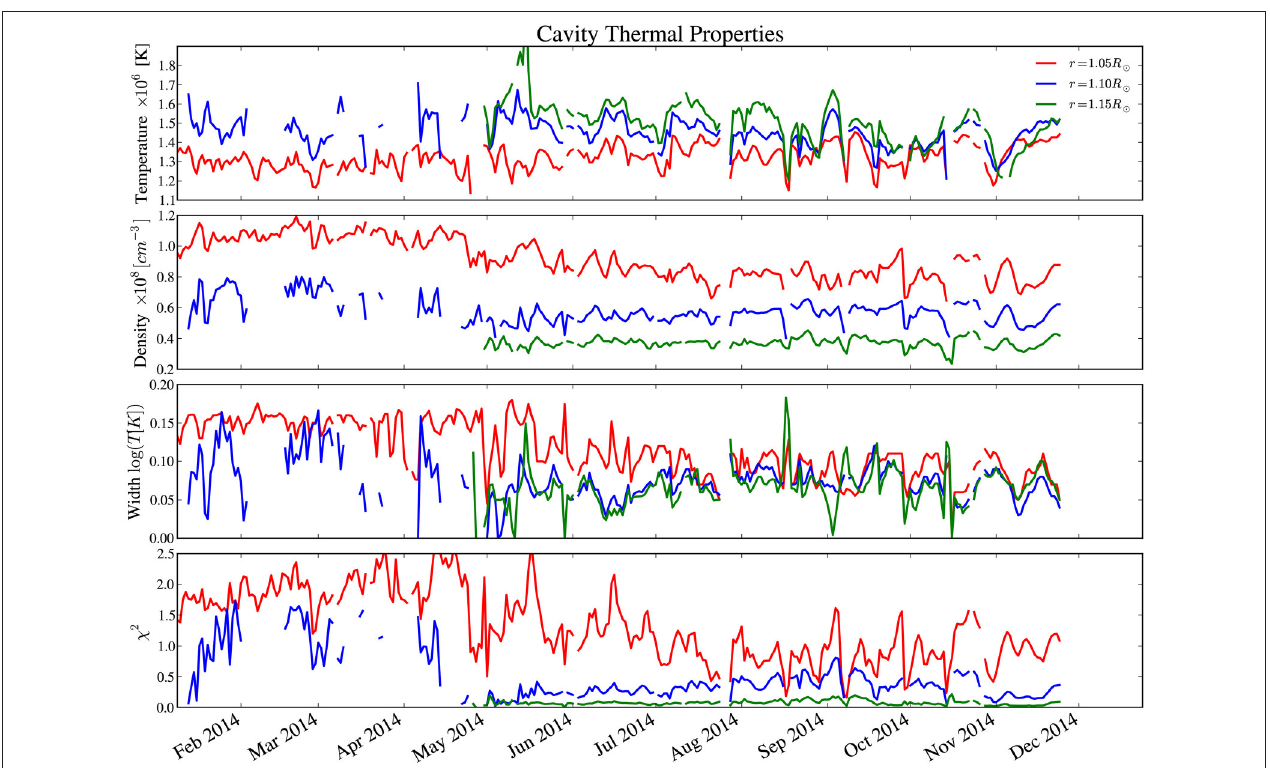
FIGURE 10 | Evolution of the cavity Gaussian DEM parameters over the ∼ 1-year lifetime of the